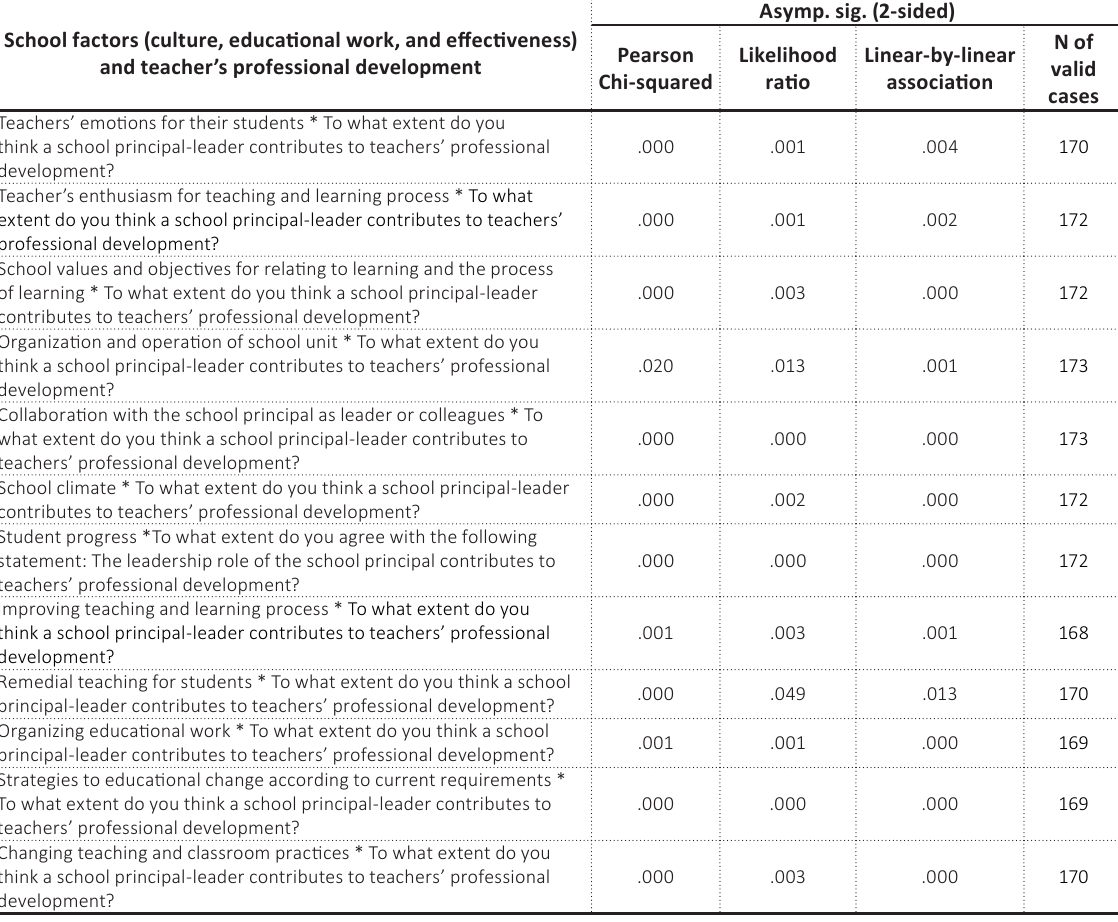
Table 8. Chi-squared analysis for hypothesis H